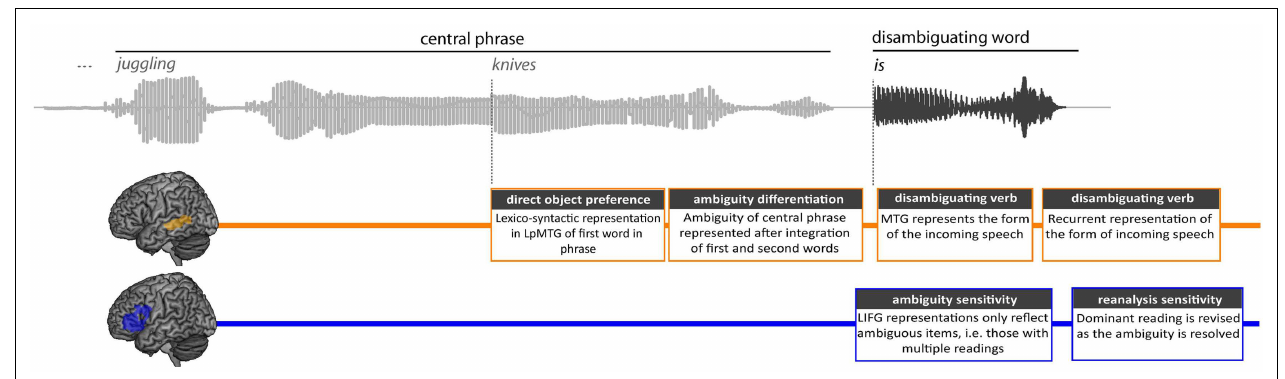
FIGURE 9 | Summary of results in the left fronto-temporal language network showing RSA effects in the LpMTG and LIFG during the central phrase and the subsequent disambiguation